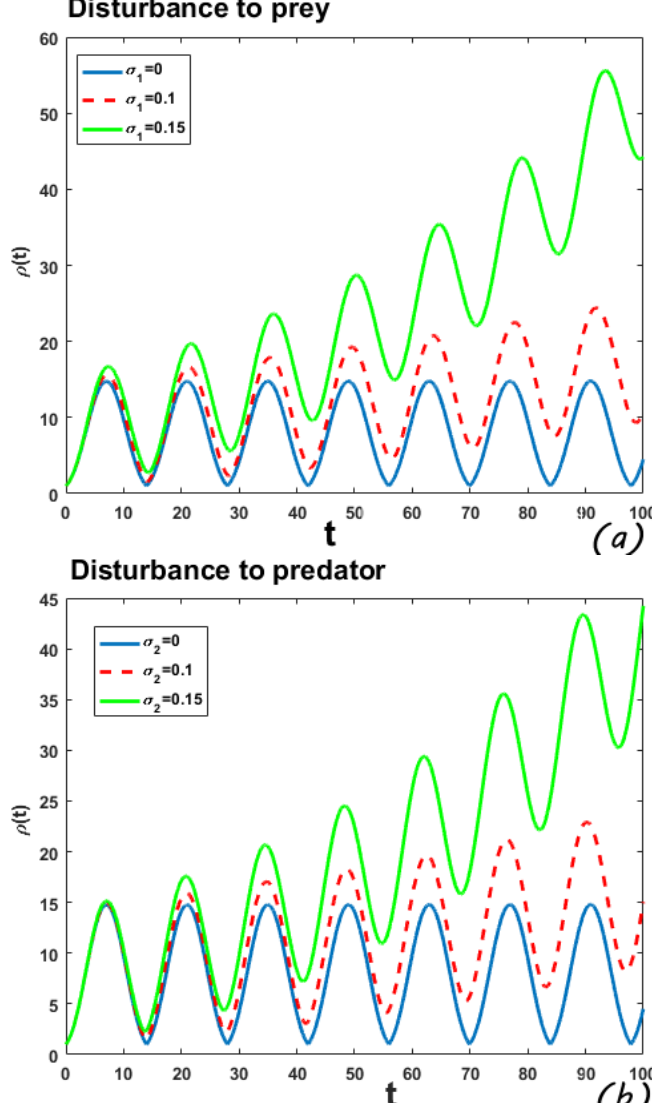
Figure 5. Root-mean-square amplification envelope of the positive equilibrium of (11). In ( a ), blue solid line: σ 1 = 0, σ 2 = 0; red dash line: σ 1 = 0.1, σ 2 = 0; green solid line: σ 1 = 0.15, σ 2 = 0. In ( b ), blue solid line: σ 1 = 0, σ 2 = 0; red dash line: σ 1 = 0, σ 2 = 0.1; green solid line: σ 1 = 0, σ 2 =